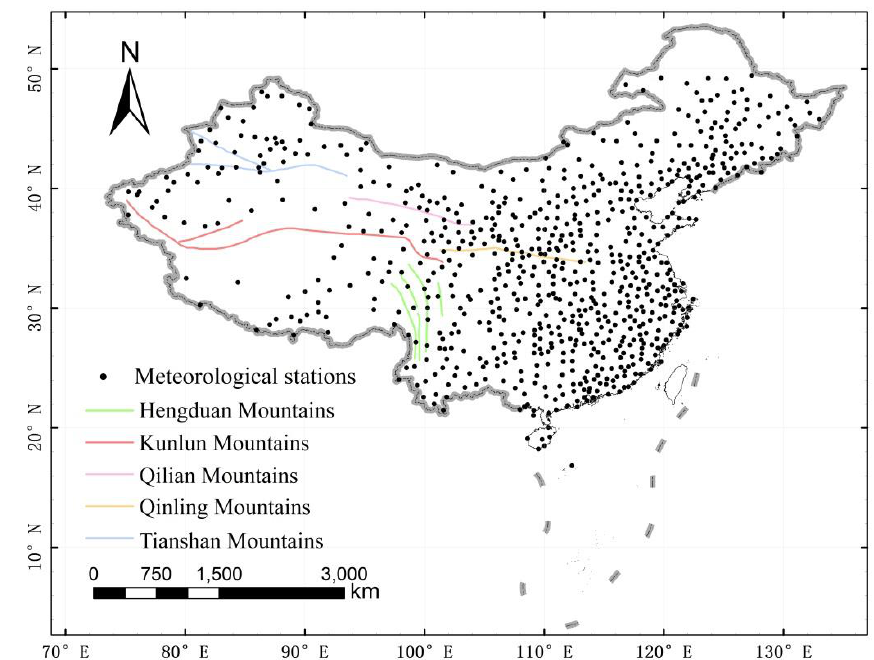
Figure 1. The diagrammatic sketch of the main mountains and distribution of meteorological stations in the study area. The datasets were obtained from China Meteorological Administration (CMA; http://data.cma.cn/en/).